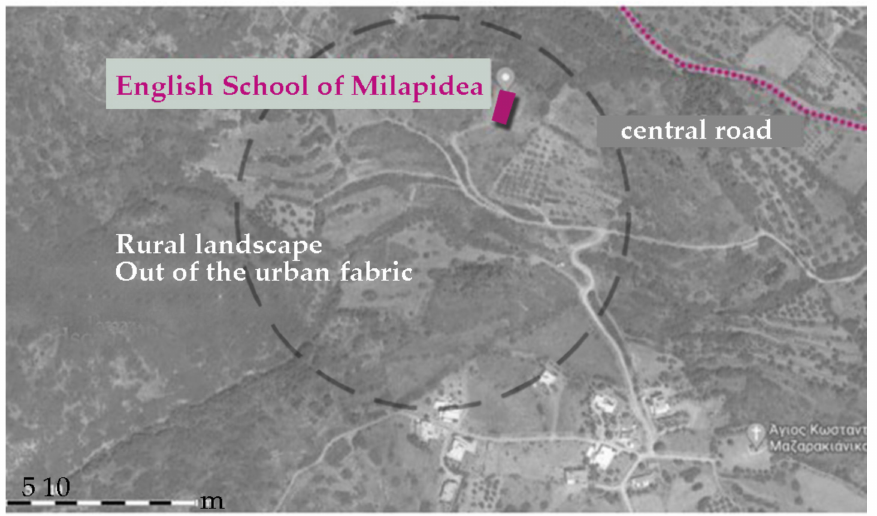
Figure 15. The location of the English School of Milapidea in Kythera, modified after